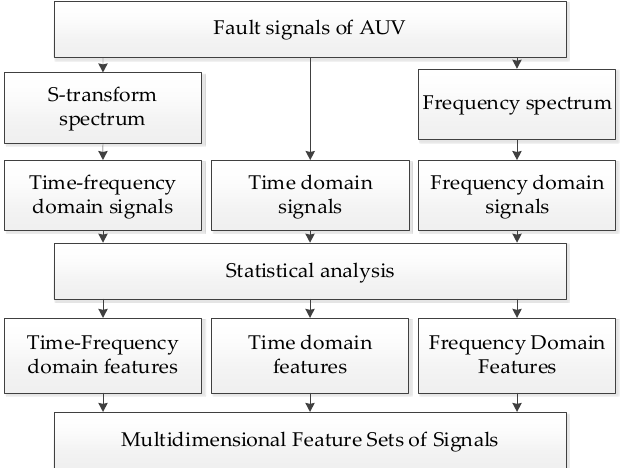
Figure 5. Process of multi-dimensional fault feature extraction.